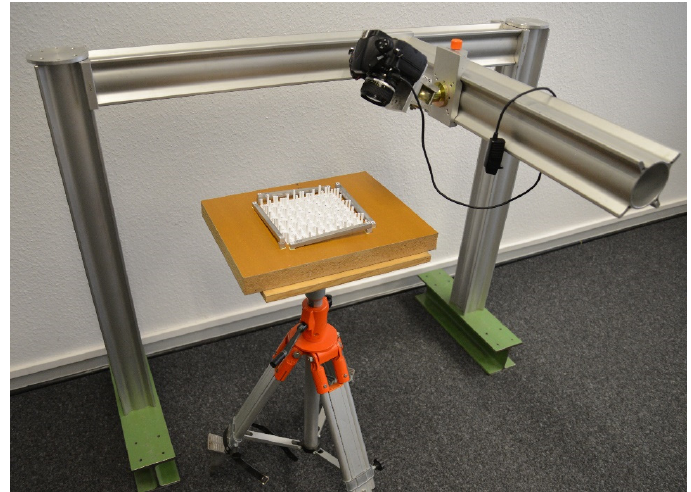
Figure 13. Measurement setup for the calibration of the 3D calibration test-field.